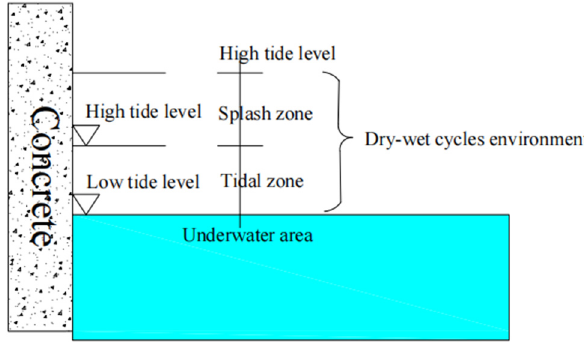
Figure 6: Schematic diagram of marine concrete service